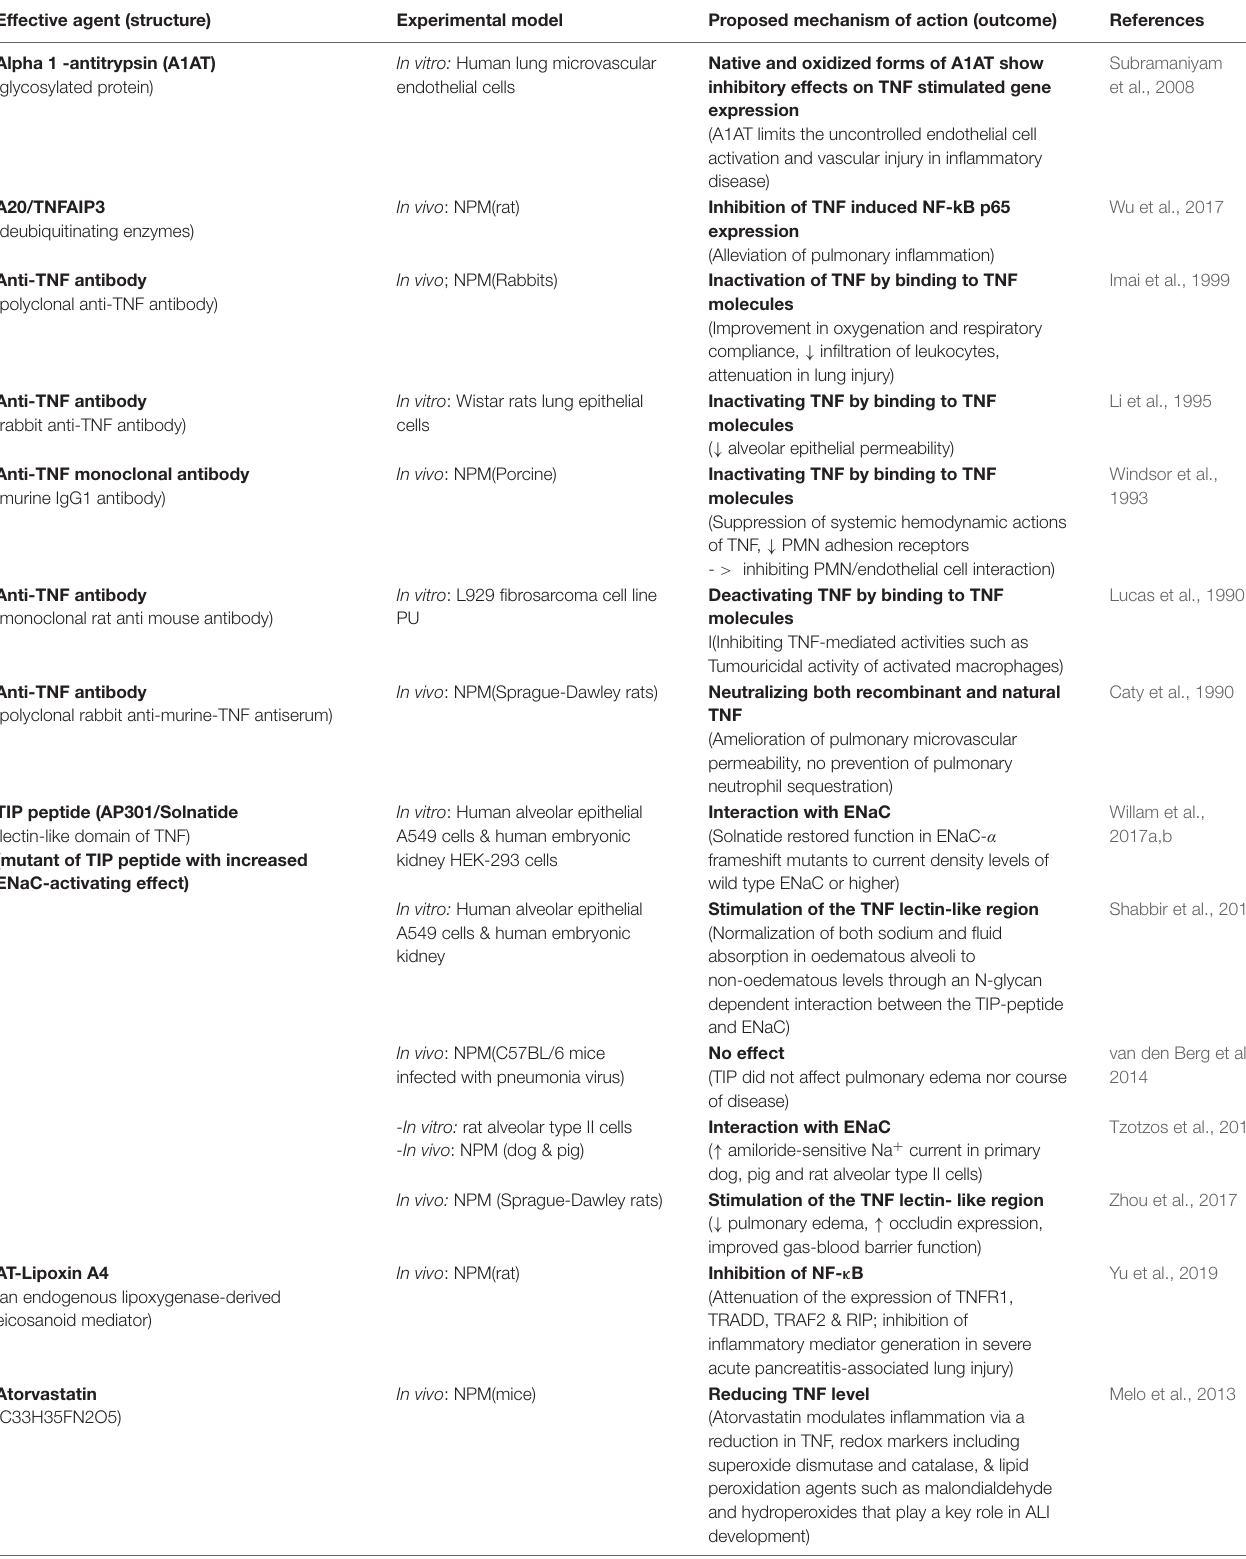
TABLE 1A | Impact of TNF inhibitors/stimulators in experimental settings using non-human models including non-human primates (NHP) and non-primates mammals